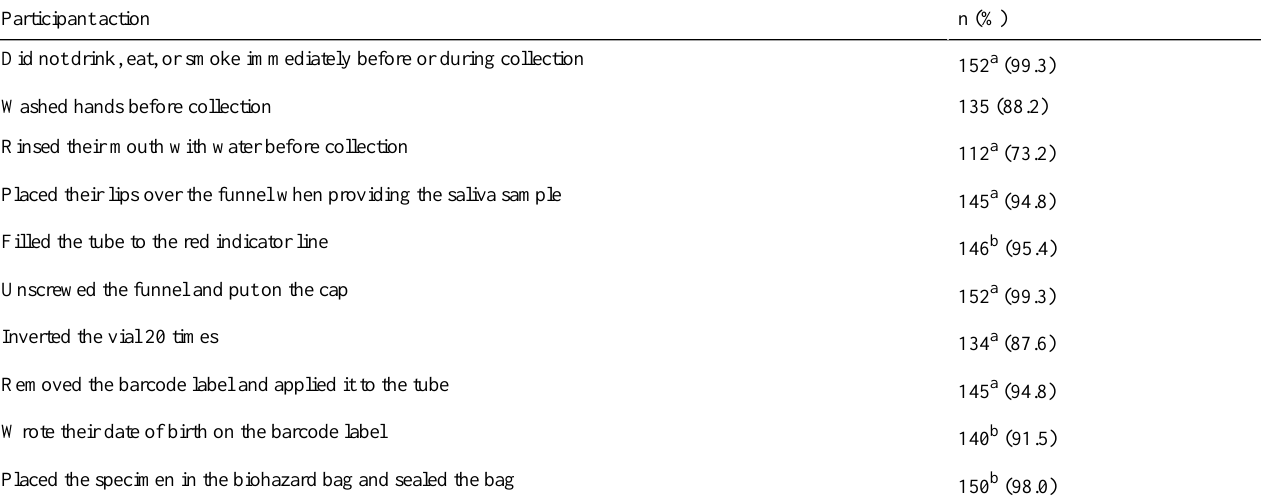
Table 5. Clinician-documented participant actions when collecting saliva samples and conducting COVID-19 self-testing during the iCollect study (n=153).